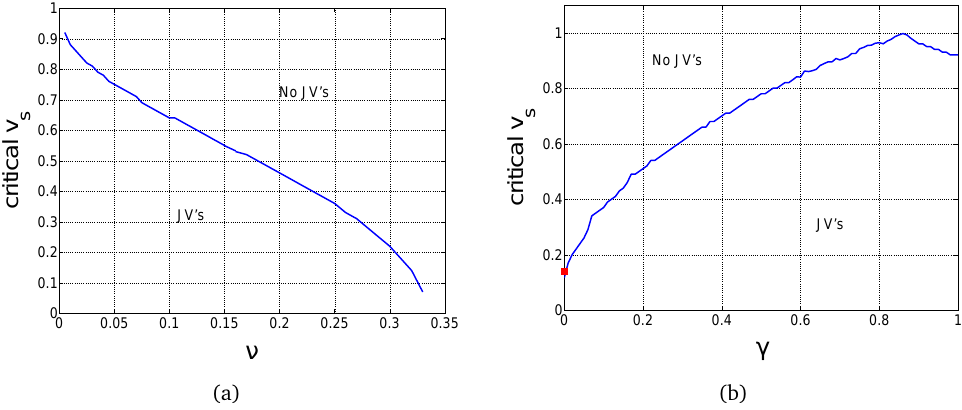
Figure 9: Critical velocity (maximum allowed speed) for Josephson vortices as a function of ν with γ = 1 (a) and as a function of γ with ν = 0.005 (b). The red square is the analytical Manakov result and the full (blue) lines are numerical